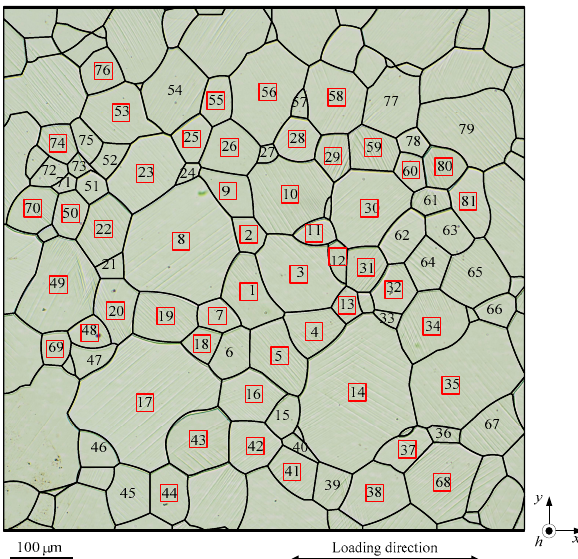
Figure 2. The specimen surface after the tensile test. The red squares indicate the evaluation areas for the average height of the grains.